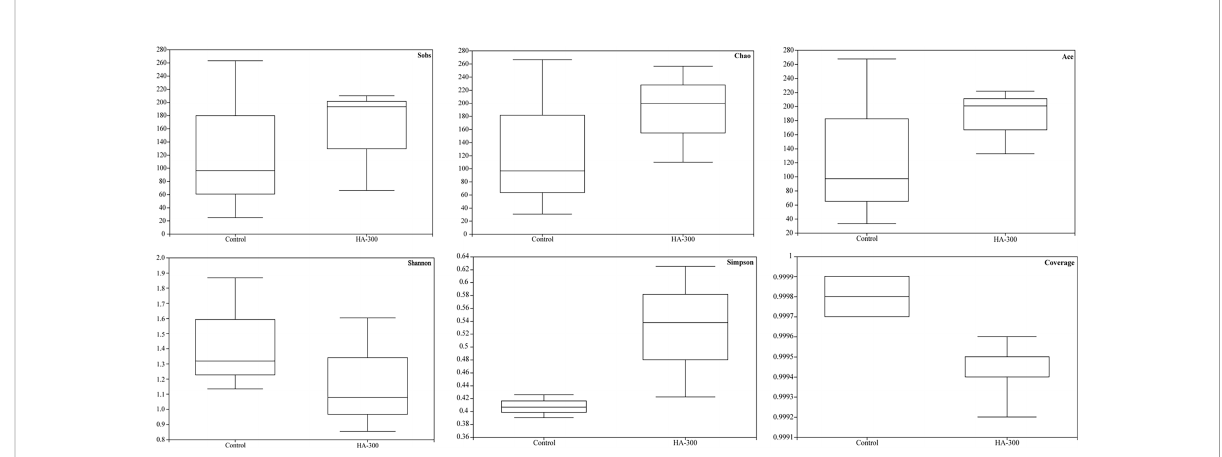
FIGURE 5 Boxplot for evaluating diversity and richness of intestinal micro fl ora of largemouth bass based on the Sobs, Chao, Ace, Shannon, Simpson, and Coverage indices (n = 3).